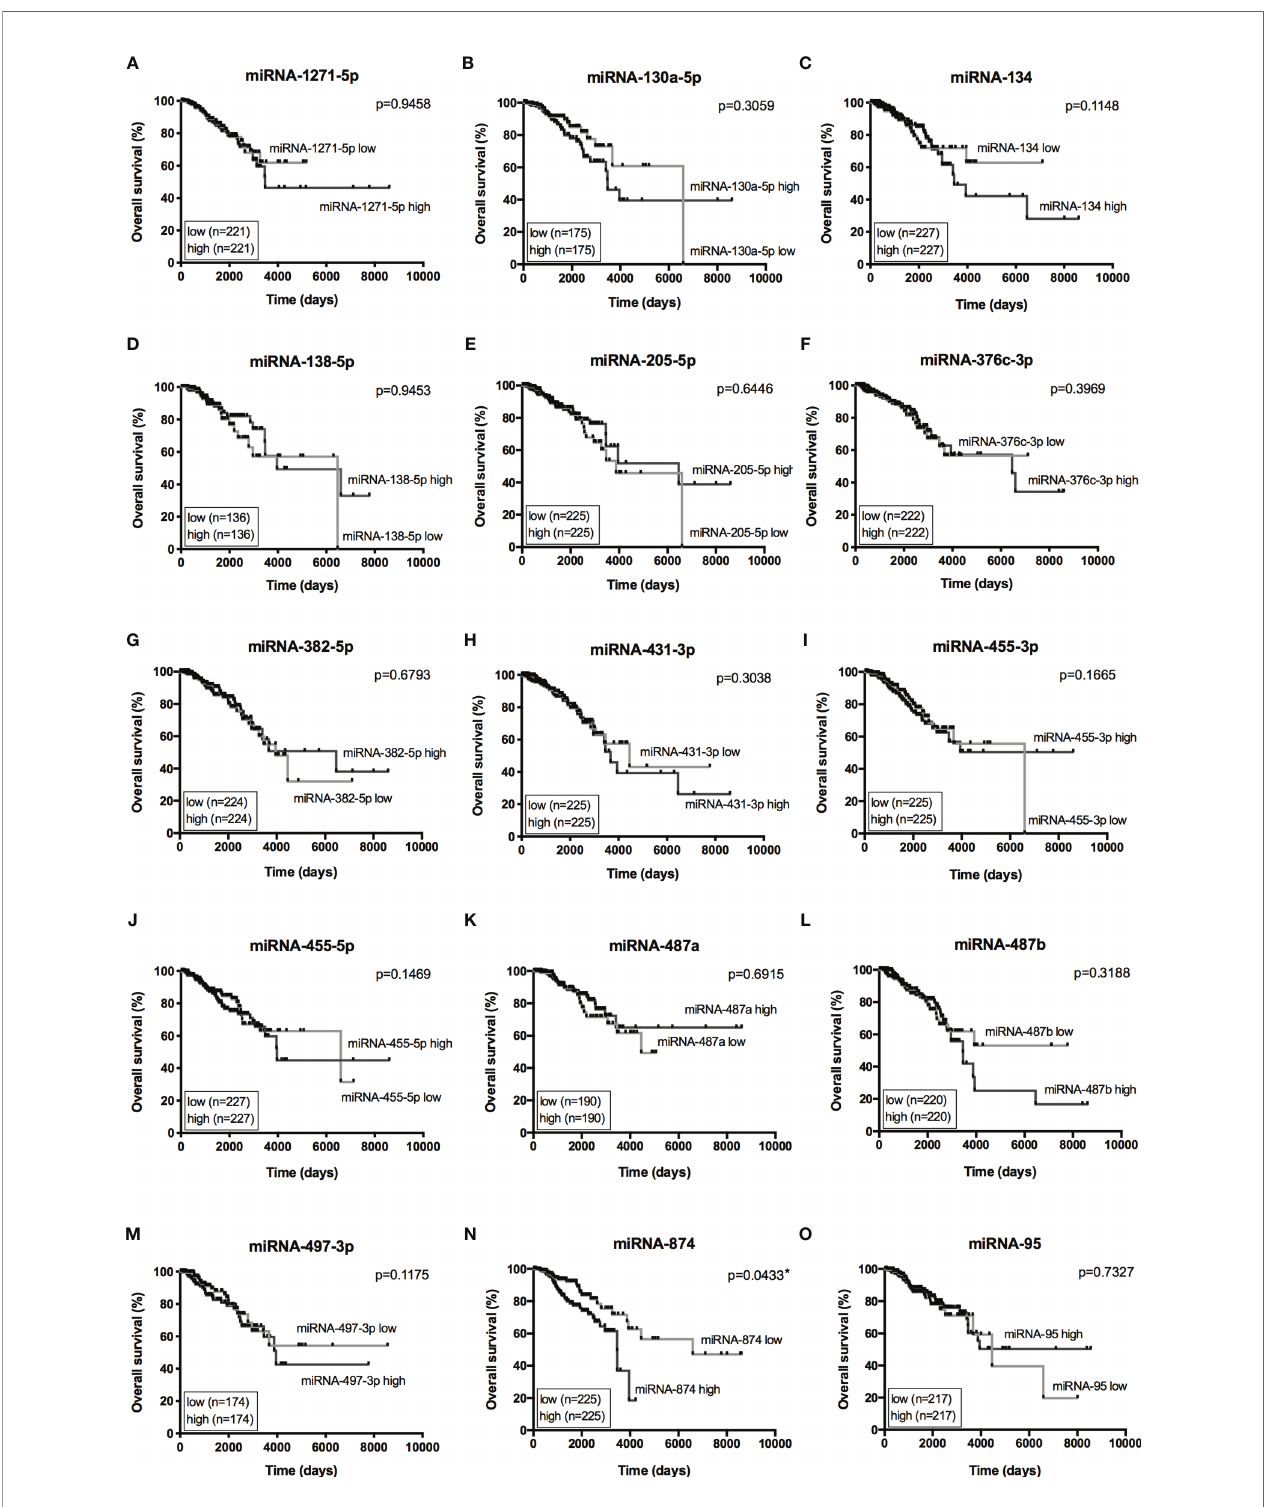
FIGURE 6 | Overall Survival curves from 15 miRNAs of interest. Kaplan-Meier curves for overall survival of TCGA-BRCA dataset with low- and high-expression of 15 miRNAs of interest. (A) miRNA-1271-5p, (B) miRNA-130a-5p, (C) miRNA-134, (D) miRNA-138-5p, (E) miRNA-205-5p, (F) miRNA-376c-3p, (G) miRNA-382-5p, (H) miRNA-431-3p, (I) miRNA-455-3p, (J) miRNA-455-5p, (K) miRNA-487a, (L) miRNA-487b, (M) miRNA-497-3p, (N) miRNA-874, (O) miRNA-95. Expression levels from LUMA, LUMB, HER2 and BASAL subtypes were determined as low or high based on quartile analysis. Statistical differences show poor overall survival (higher risk) for patients with a speci fi c miRNA expression (high or low). *p <